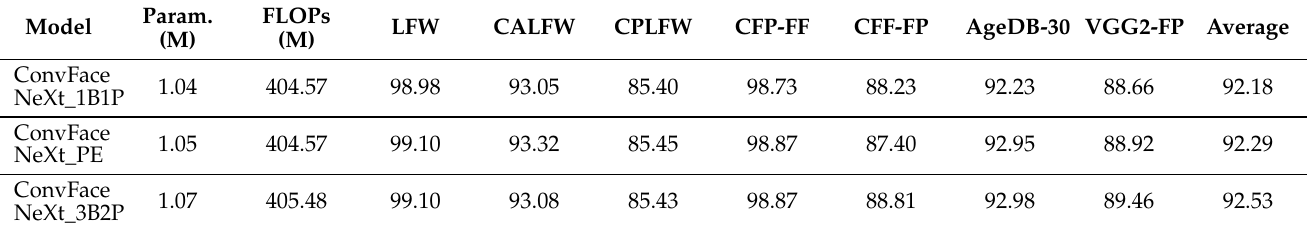
Table 8. Performance results for different amounts of batch normalisations and activation functions. These results are reported in terms of parameters, FLOPs and verification accuracy for LFW, CALFW, CPLFW, CFP-FF, CFP-FP, AgeDB-30 and VGG-2FP. Aside from that, the average accuracy for the seven image-based datasets is shown in the last column. Here, ‘1B1P’ denotes the ECN block with one batch normalisation and one PReLU activation, the model in the second row utilizes two batch normalisations and one activation function in the ECN block, and ‘3B2P’ denotes three batch normalisations and two PReLU activations.